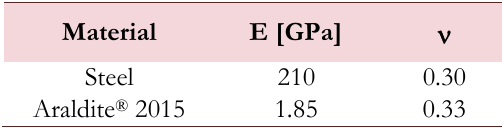
Table 1: Adherend and adhesive mechanical properties.